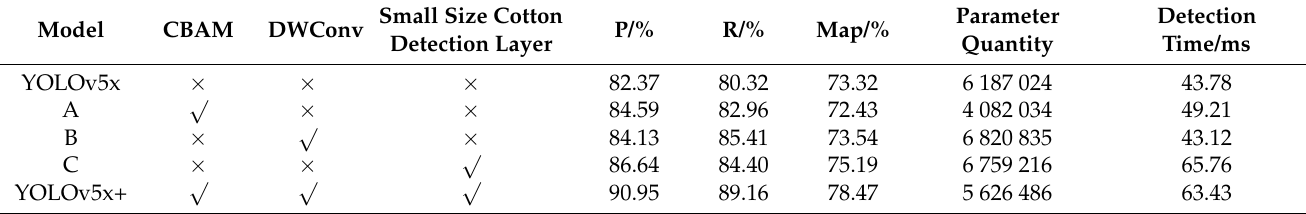
Table 2. Ablation test results.